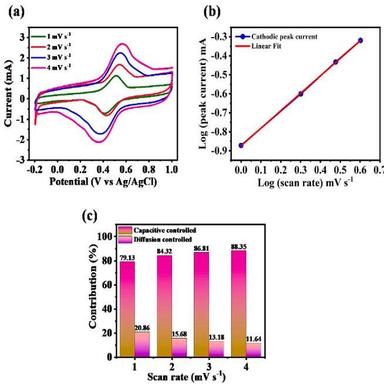
(a) CV curves of PDI-NDI-PDI/GF electrode at various low scan rates; (b) the cathodic peak current (Ip) with scan rate for PDI-NDI-PDI/GF; (c) relative contributions of the capacitive and diffusion-controlled charge storage processes at different scan rates.